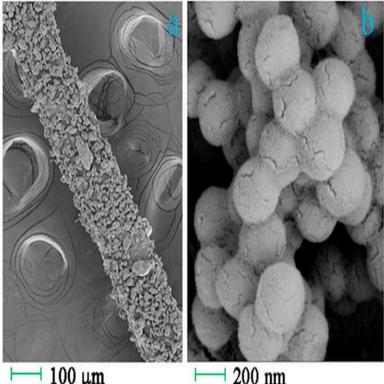
Coating fiber (a) and UiO-66-OH (b) SEM images used for the microextraction of PBDEs from milk.